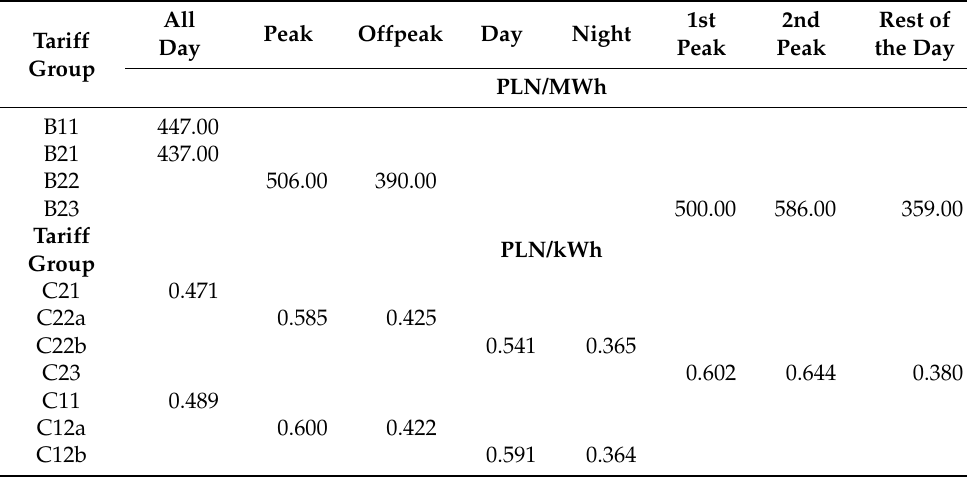
Table 3. Sales tariffs included in the calculations